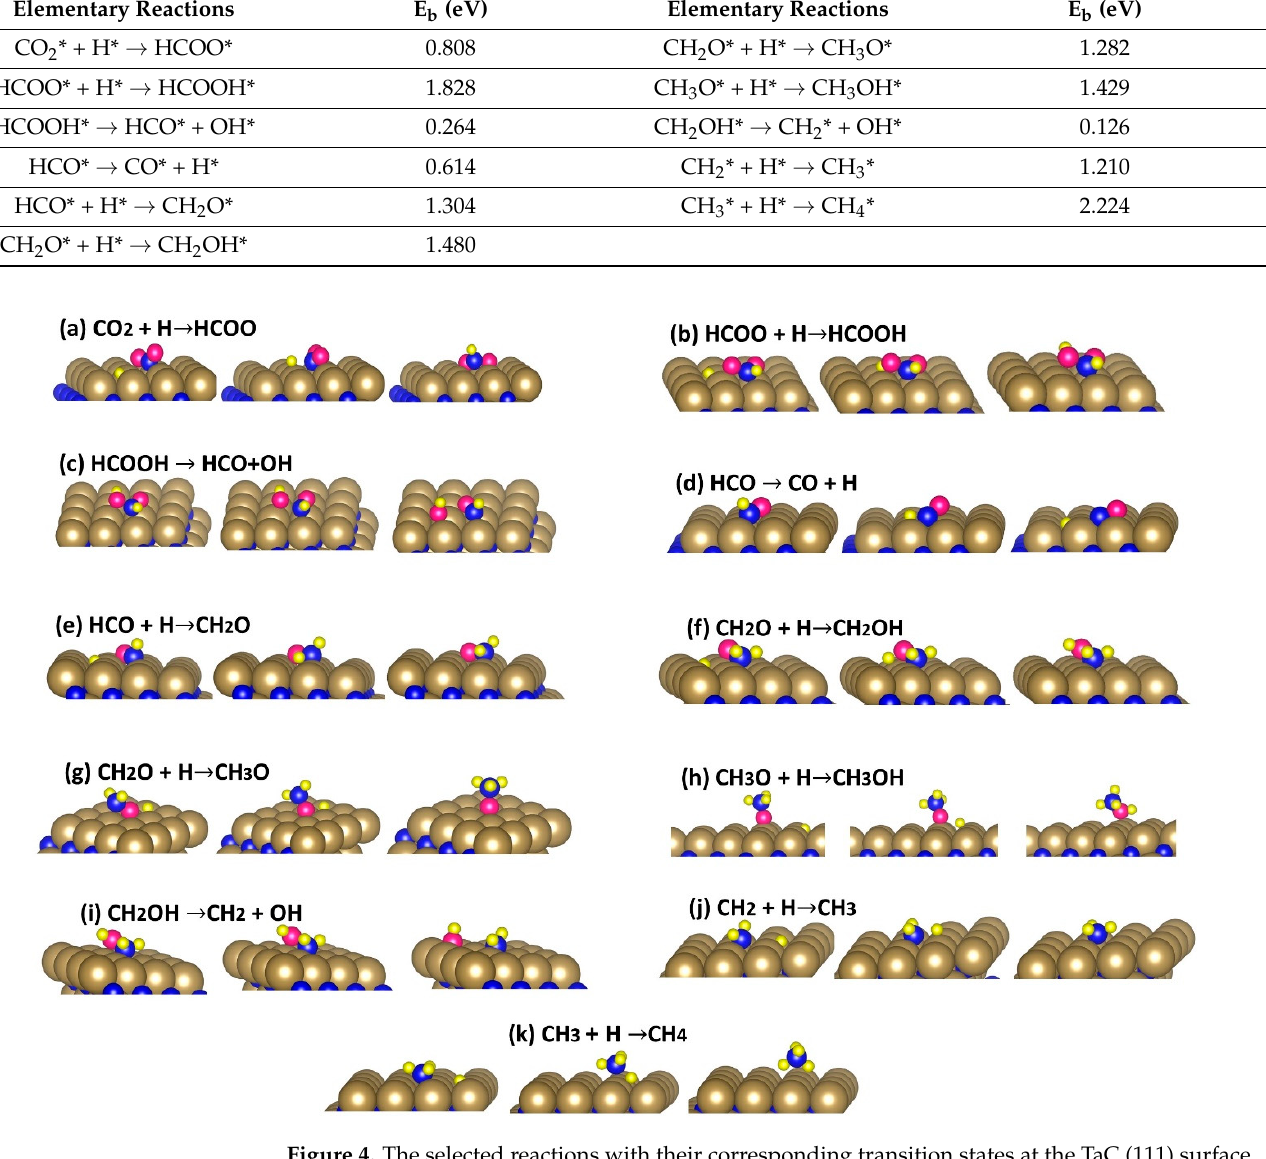
Figure 4. The selected reactions with their corresponding transition states at the TaC (111) surface.